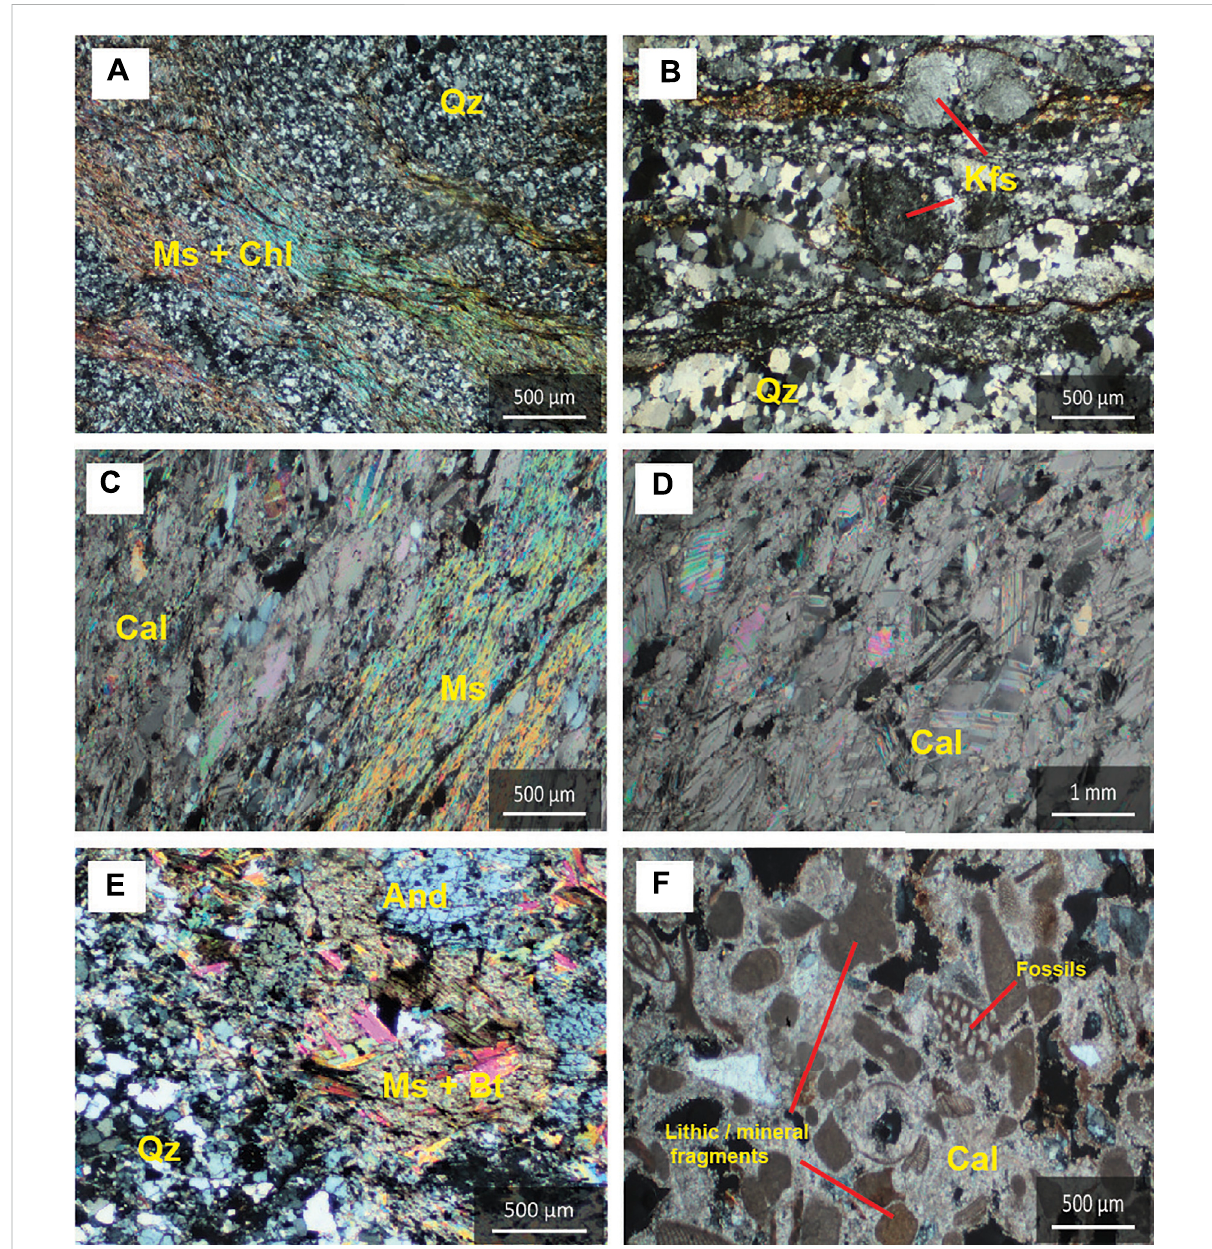
FIGURE 10 Petrographic features of metamorphic and sedimentary rocks described in the itinerary. (A) Layering in a metapelite from the Bithia Unit, with quartz-feldspar layers and muscovite-chlorite layers that mark the main foliation; (B) sample of the Monte Filau orthogneiss from stop 3 showing a rotated K-feldspar porphyroblast in a K-feldspar+quartz matrix, with phyllosilicates marking the foliation; (C) marble from stop 1, with muscovite fl akesthatmarkthefoliationandthematrixofcalcitecrystals; (D) marblefromstop6withalesseramountofmuscoviteandahigheramountof calcite withrespect to (C) ; (E) samplefromstop3ofthe Settiballas Schists,withalayercomposedofandalusite+ muscovite+ biotiteincontactwith a quartz-feldspatic layer; (F) sample from stop 7 of the quaternary sandstones, with the carbonate matrix which includes lithic clasts, quartz crystals, and